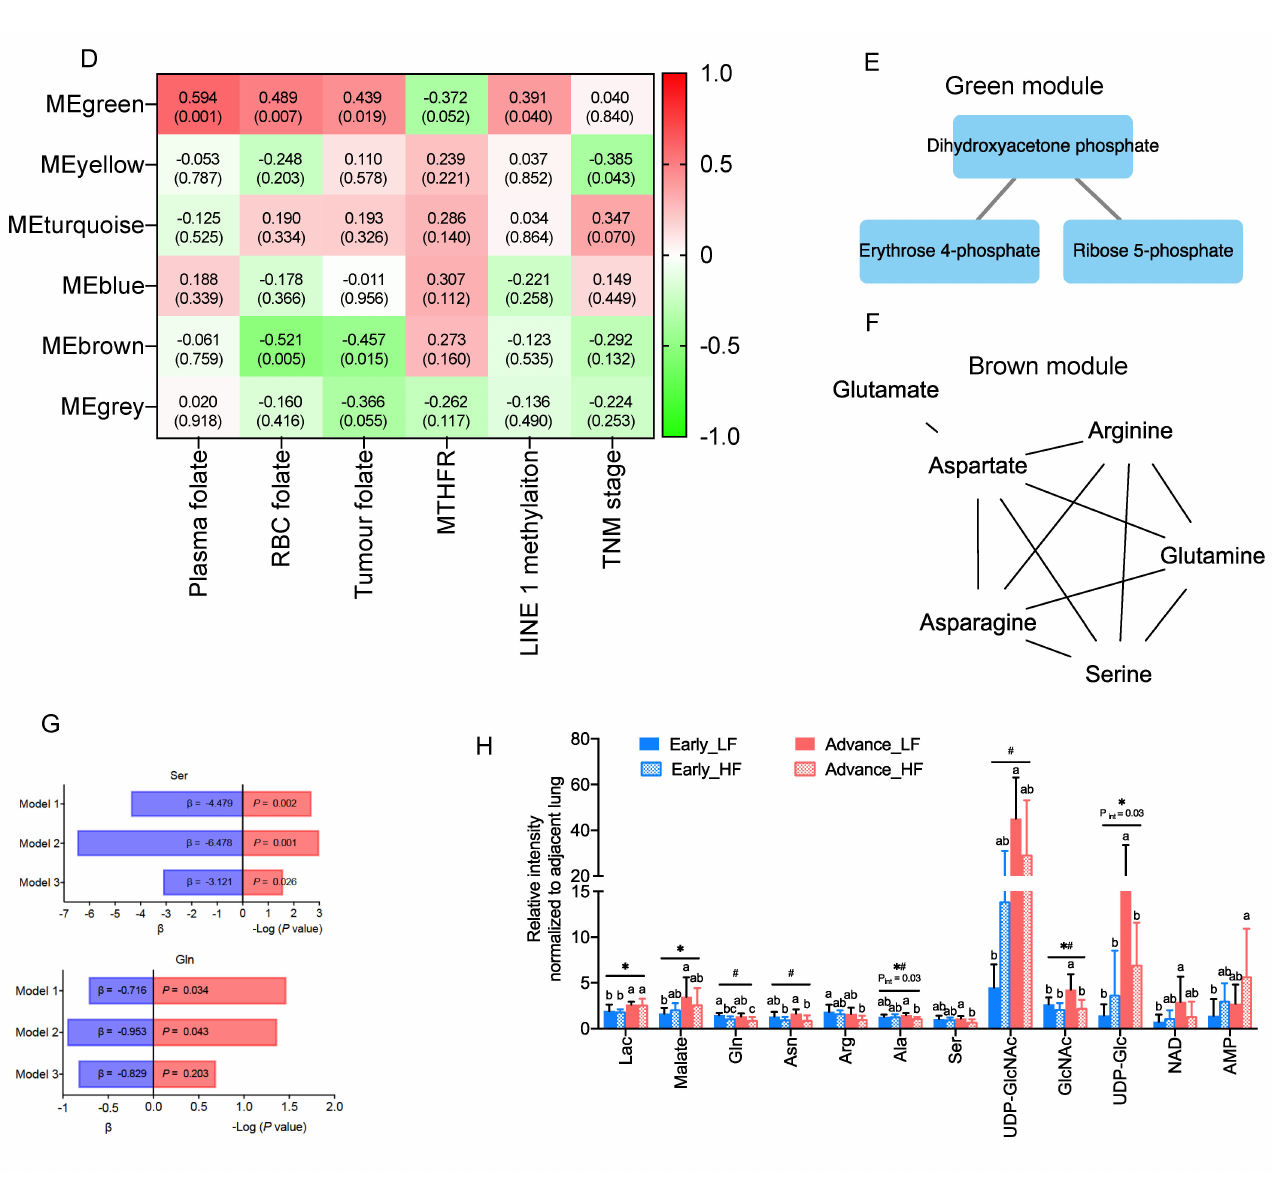
Figure 2. Association of clinical folate trait with stage-sensitive tumour markers in NSCLCs. ( A ) OPLS-DA of paired NSCLCs stratified by tertile tumour folate. Relative abundance of metabolites in ( B ) central carbon and ( C ) glycolytic amino acids metabolisms among tertile tumour folate-stratified NSCLCs. Signal intensity of the designated tumour metabolites was normalized with each paired adjacent lung. Z-scored values were expressed as mean ± SD. ( D ) Identify metabolite modulates associated with clinical folate traits by weighted gene co-expression network analysis (WGCNA). Each row stands for a module metabolite (MM), and each column represents a clinical folate marker. Each long square contains the correlation coefficient with p value in parenthesis. Differential enriched metabolites network in the clinical folate-associated ( E ) green and ( F ) brown module. Red block represents the hub metabolites. ( G ) Multivariable linear regression models were constructed to analyse the association of tumour folate with glutamine and serine. Model 1: adjusted for age, sex, smoking status, and BMI. Model 2: additional adjustment for plasma folate; Model 3: additional adjustment for genomic epigenetic mark ( LINE1 methylation) and genetic polymorphism of MTHFR 677CT/TT genotypes. ( H ) Interaction of tumour folate and TNM stage analysed by two-way